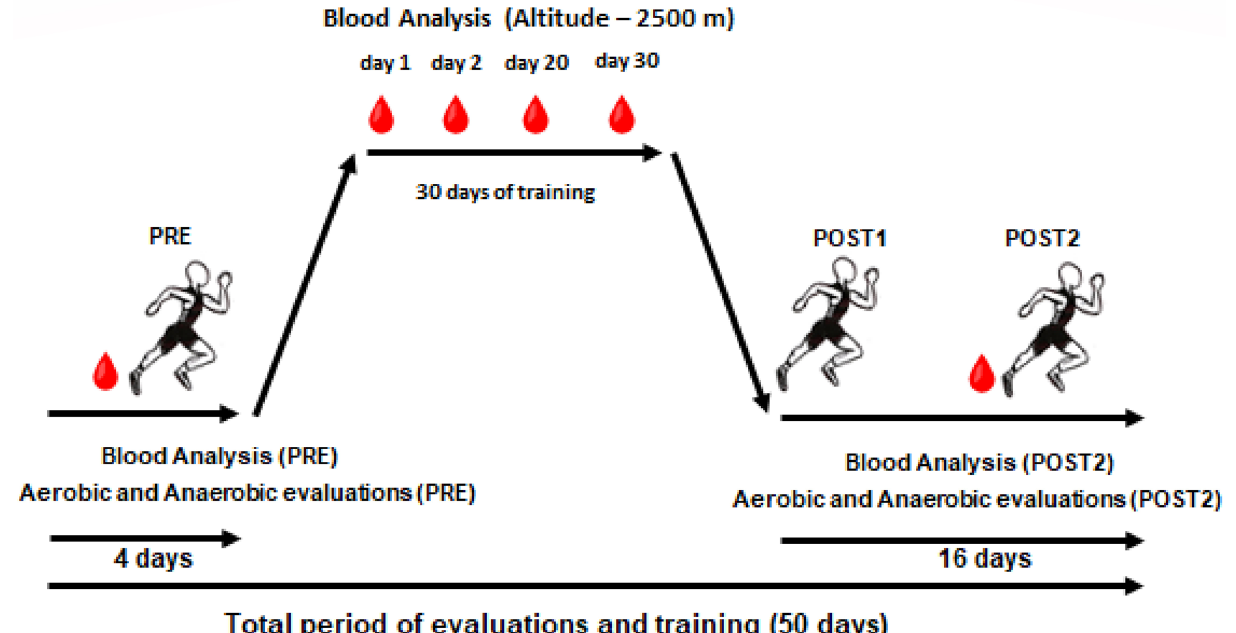
Figure 1. Hematological and physical performance evaluations performed before (PRE), the ascent to altitude, during the stay in Colombia (2500 m) and after returning to lower altitudes (POST). Procedures performed during the entire period of training and evaluations. Assessment schedules: PRE-days -2 and -1 (before the altitude period), POST1-days 5 and 6 (after the altitude period), POST2-days 15 and 16 (after the altitude period). For these moments, the sequential tests performed were anaerobic (AO30) and aerobic (3000 m),